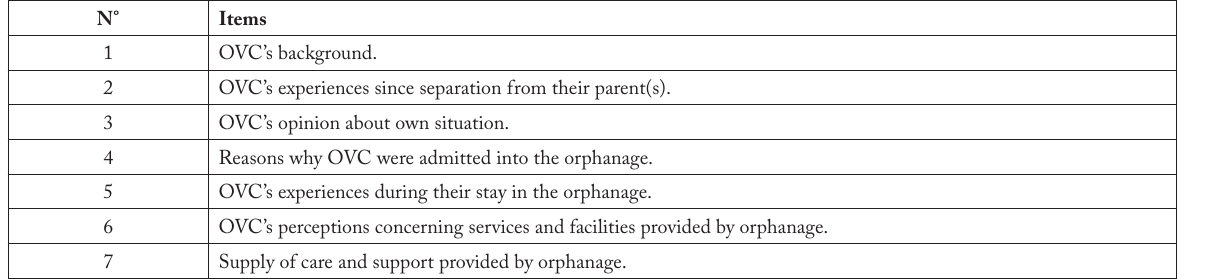
Table 1. Checklist for In-depth